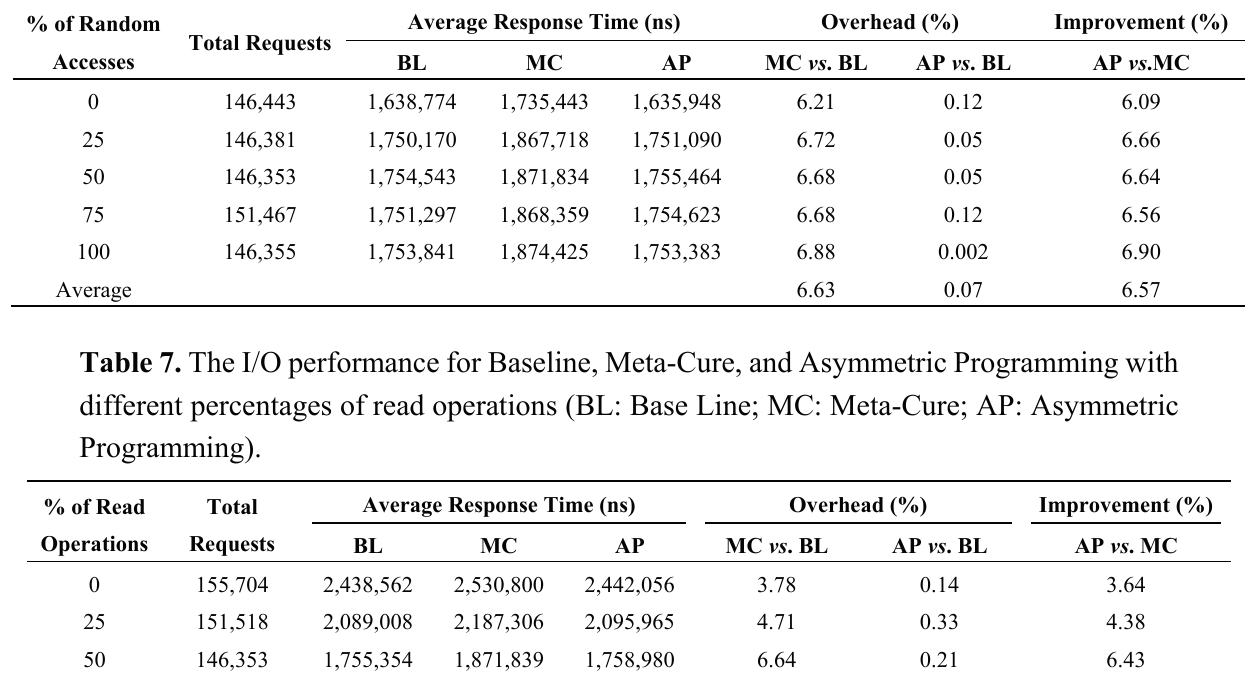
Table 6. The I/O performance for Baseline, Meta-Cure, and Asymmetric Programming with different radios of random accesses (BL: Base Line; MC: Meta-Cure; AP: Asymmetric Programming).